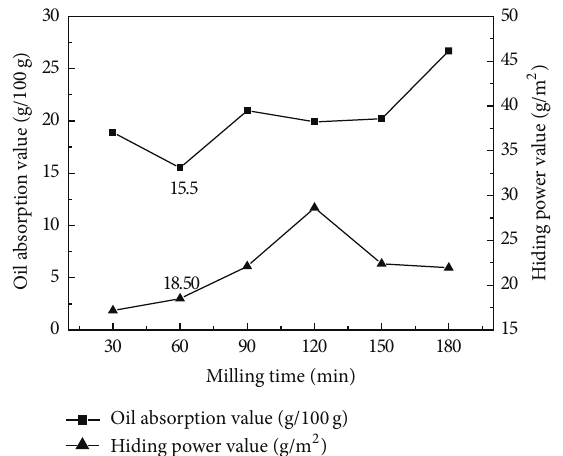
Figure 2: Effect of grinding time of barite on pigment properties of B/TCP.